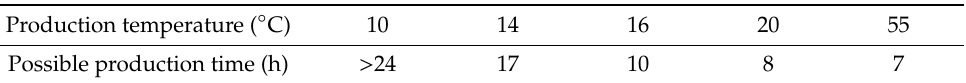
Table 1. Possible production time as a function of temperature ( ϑ = 10–55 ◦ C) with limits set by the colony-forming unit count or pH.